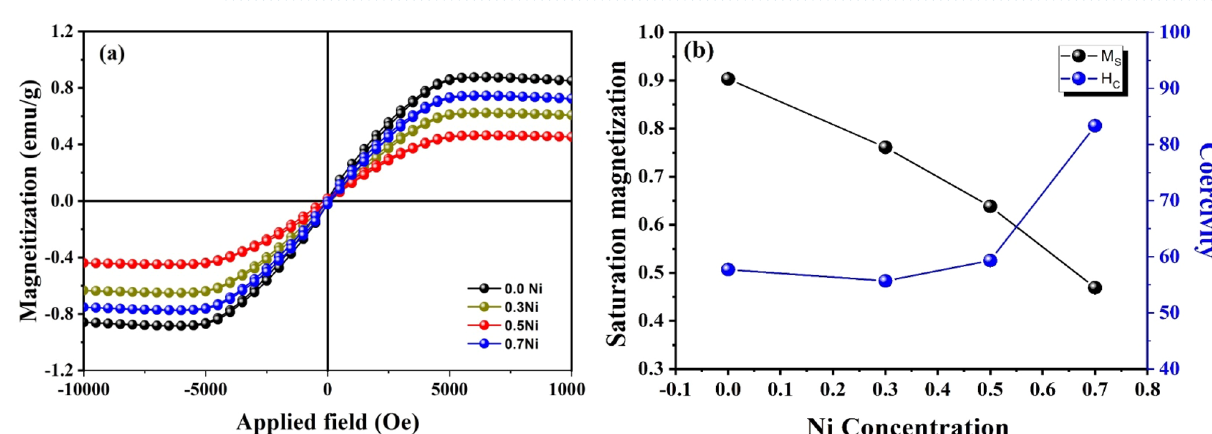
Figure 7. ( a ) The magnetic hysteresis loops of the prepared SMZC: (0, 0.5, 0.7)Ni 2+ nanoceramics within the field sweeping of ± 10 kOe, and ( b ) the propagation of the saturation magnetization and coercivity in terms of the Ni